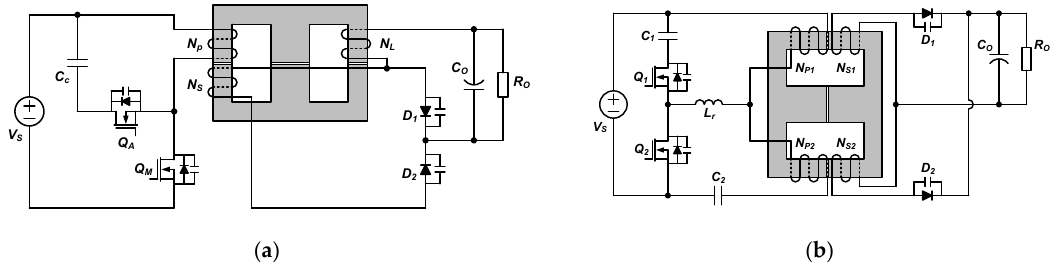
Figure 3. Conventional active-clamp-forward (ACF) converters with integrated magnetics. ( a ) Integration of a transformer and an output inductor [16]. ( b ) Integration of two transformers [17].